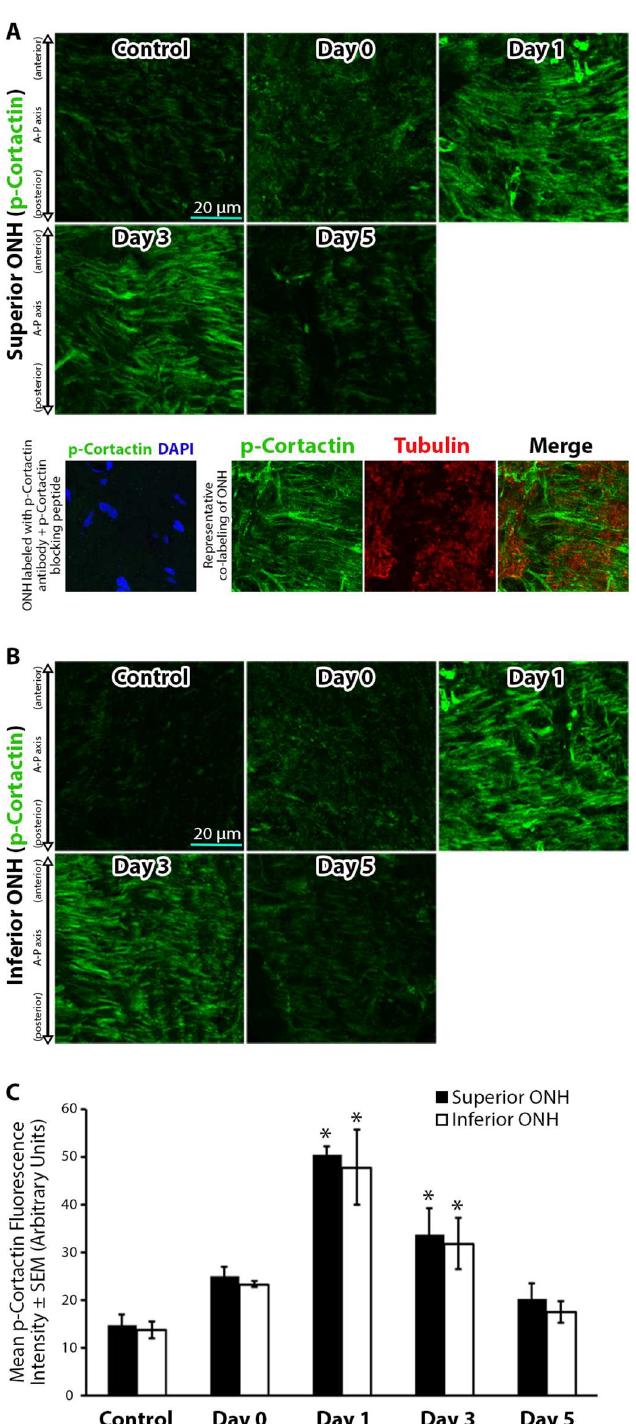
Fig 6. Cortactin phosphorylation levels within the optic nerve head increasein a reversible manner after intraocular pressureelevation. (A-B) Superiorand inferior optic nerve head(ONH) sections labeled with anti-phosphorylated cortactin (p-cortactin) antibodiesin control eyes and eyes exposedto 8 hours of intraocular pressure(IOP) elevation. The bottom panelsin (A) includea validationof antibody specificity using a p-cortactin specific blockingpeptide(bottom left panel), as well as an exampleof co-labeling with p-cortactin and axon specific anti-tubulinantibodiesto demonstrate the non-axonal source of the majority of